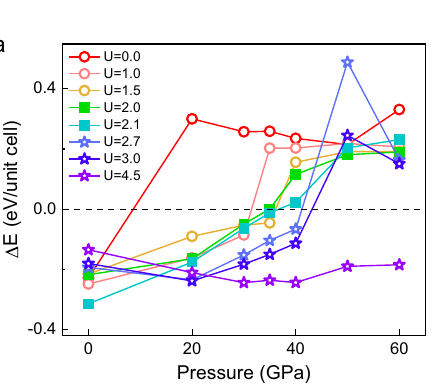
function of pressure for La 2 O 3 Fe 2 Se 2 . The black dashed line is a fi tted curve by the Birch-Murnaghan equation of state with the derived bulk modulus B 0 =73.9GPa. The inset shows the pressure dependenceof the c/aratiowhichshows ananomaly ~40GPa, close to the insulator-metal transition.